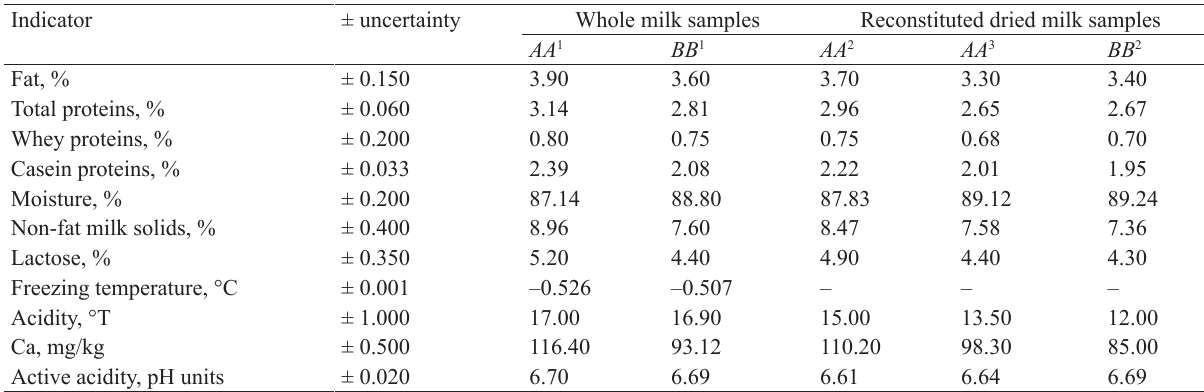
Table 1 Physicochemical composition of whole milk and reconstituted dried milk samples Indicator ± uncertainty Whole milk